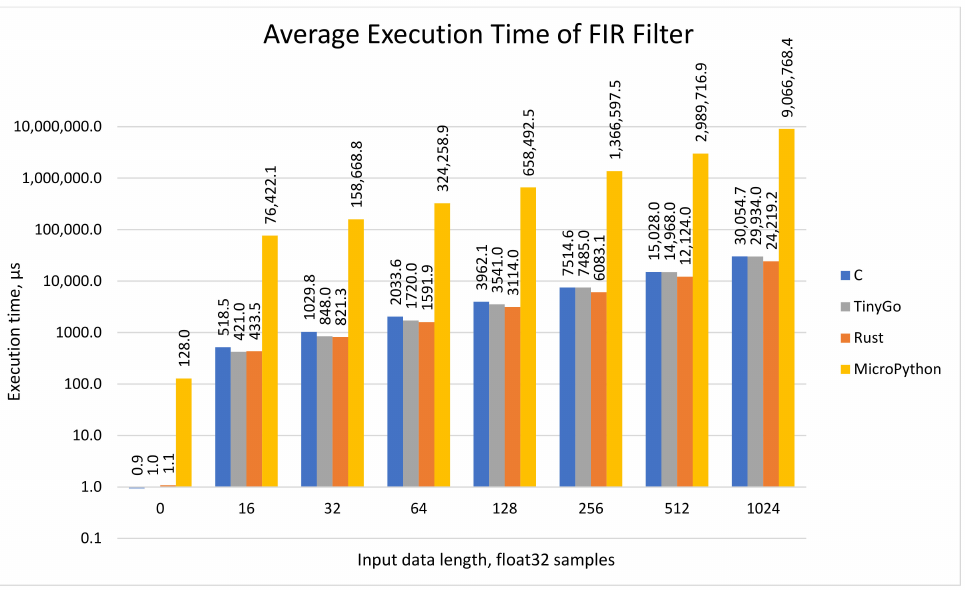
Figure 8. Average execution times of the FIR filter algorithm (please note the logarithmic time scale).